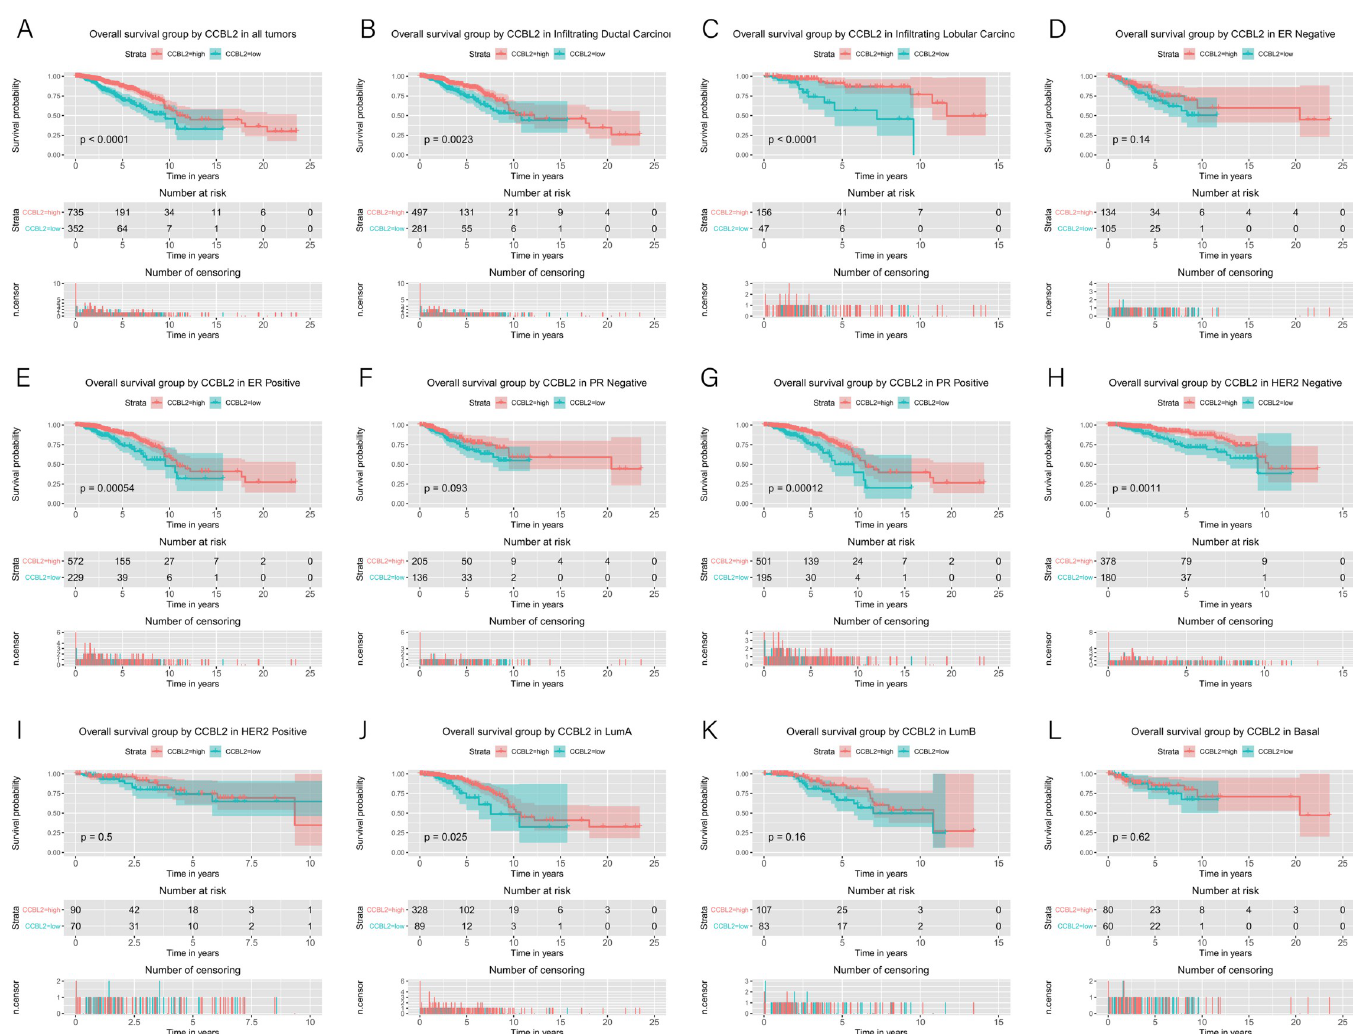
Fig 5. Kaplan–Meier curves of overall survival in breast cancer according to CCBL2 expression in breast cancer tissues. Overall survival analysis and subgroup analyses of histological type (B and C), ER (D and E), PR (F and G), HER-2 (H and I) and molecular subtype (J, K and L). High CCBL2 expression had relations with the high overall survival. (p < 0.0001)